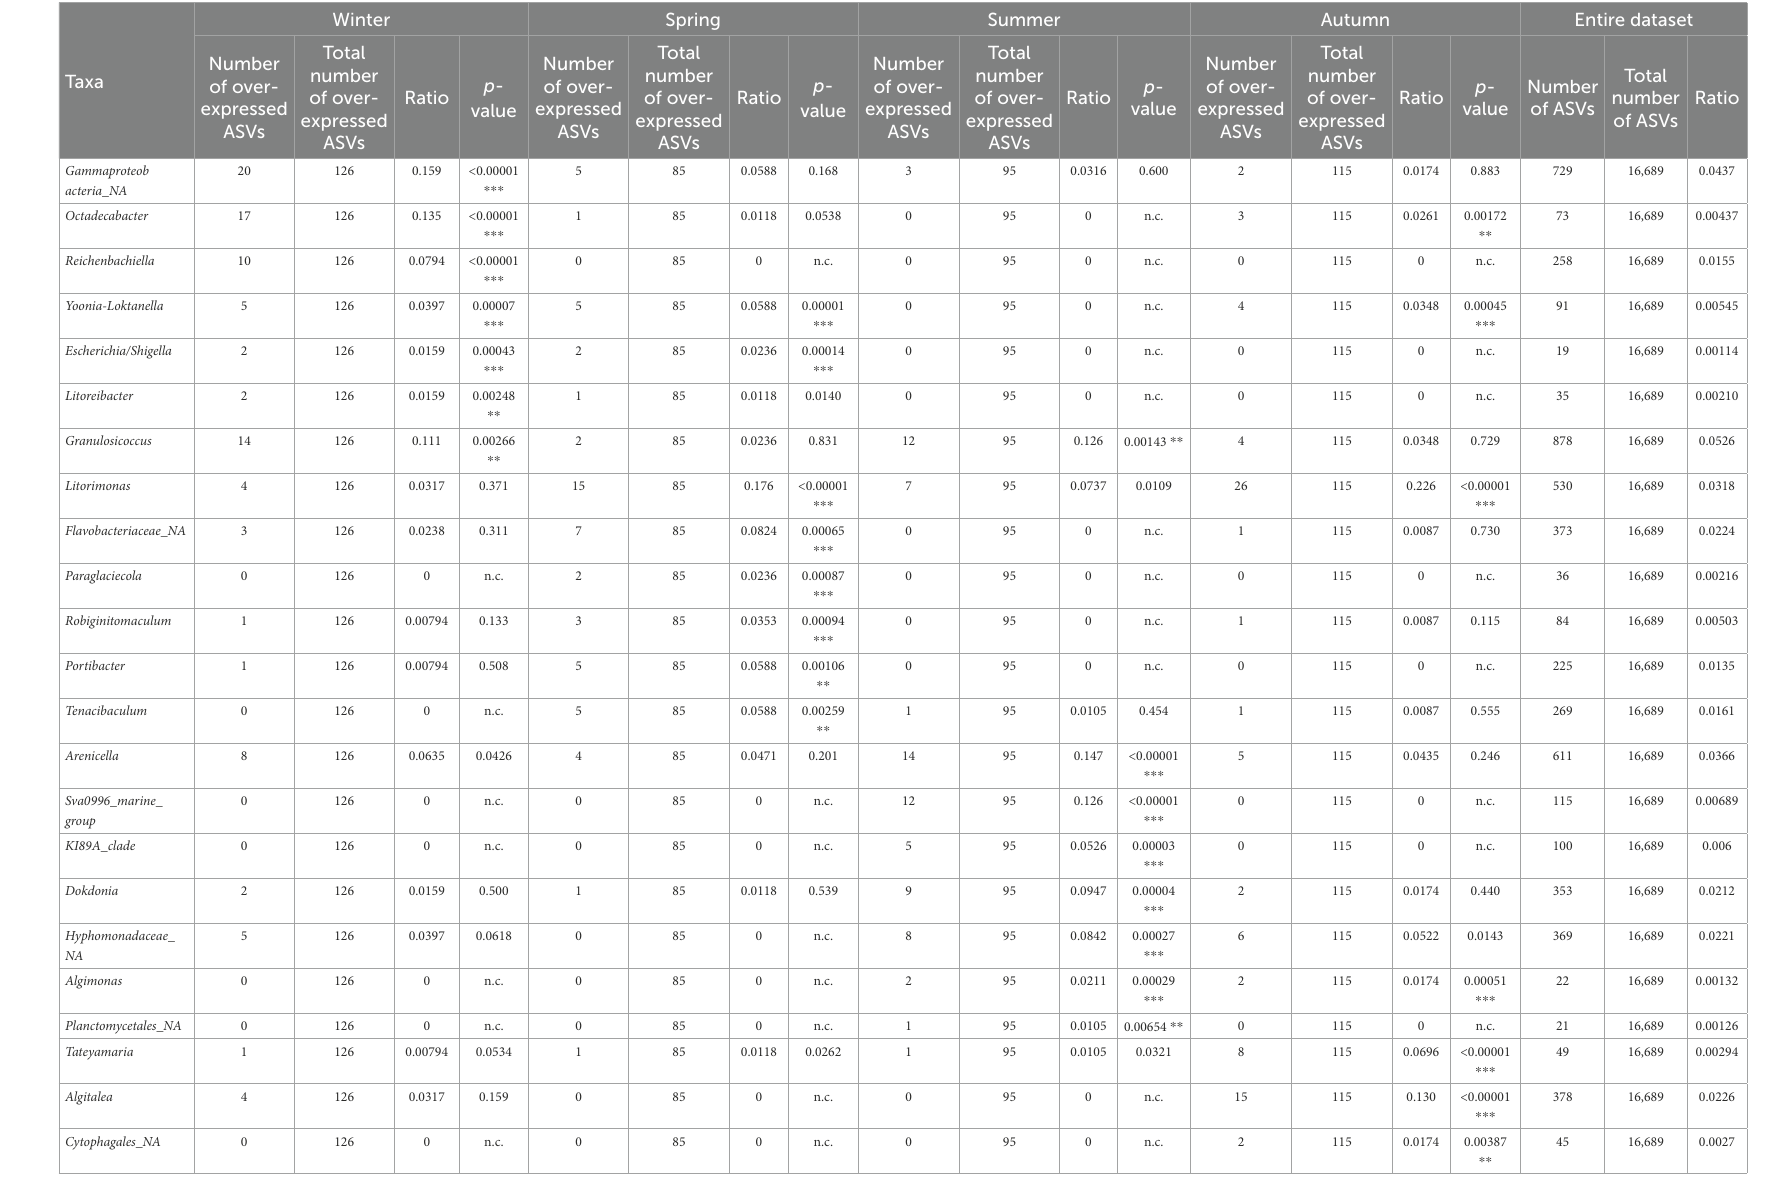
TABLE 4 Taxonomic affiliations of the ASVs characteristic for each season from Roscoff samples, compared with their occurrence in the entire dataset.